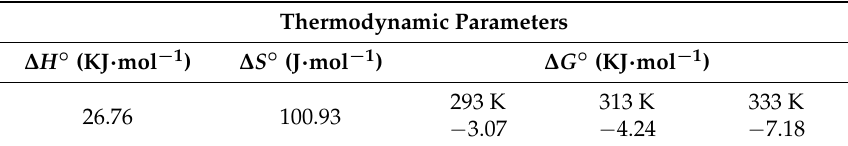
Table 8. Thermodynamic parameters for Cu 2+ -CNF system.